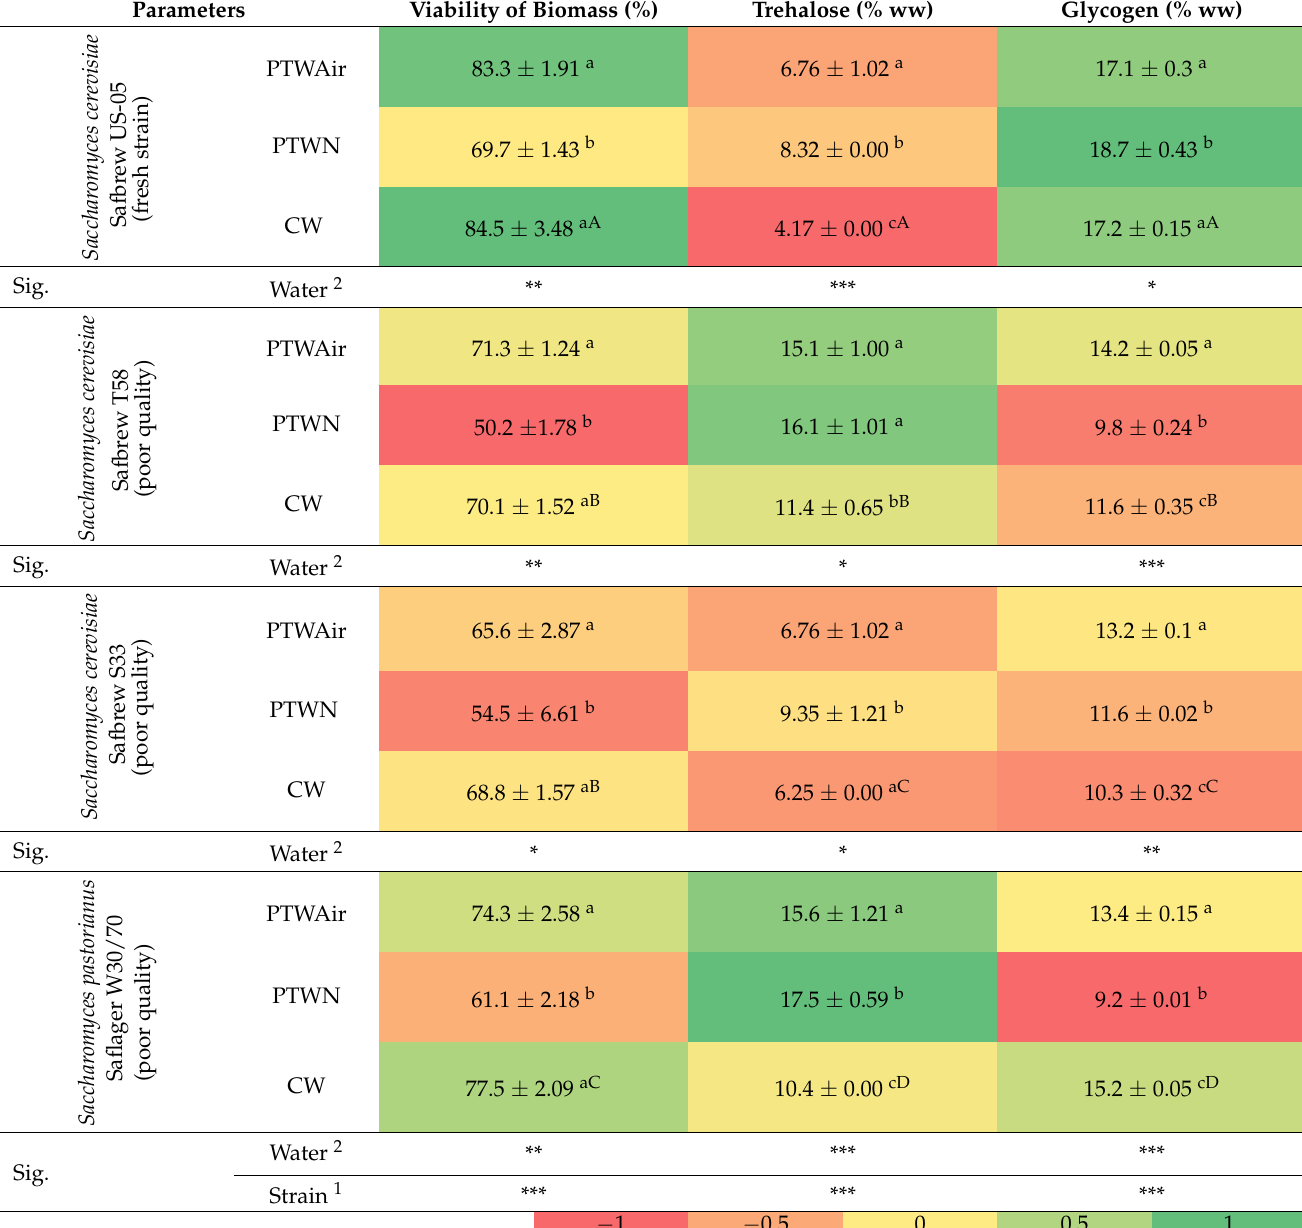
Table 3. Quality parameters of yeast biomass Saccharomyces cerevisiae (T58, US-05, S33) and Saccha- romyces pastorianus (W30/70) after fermentation.